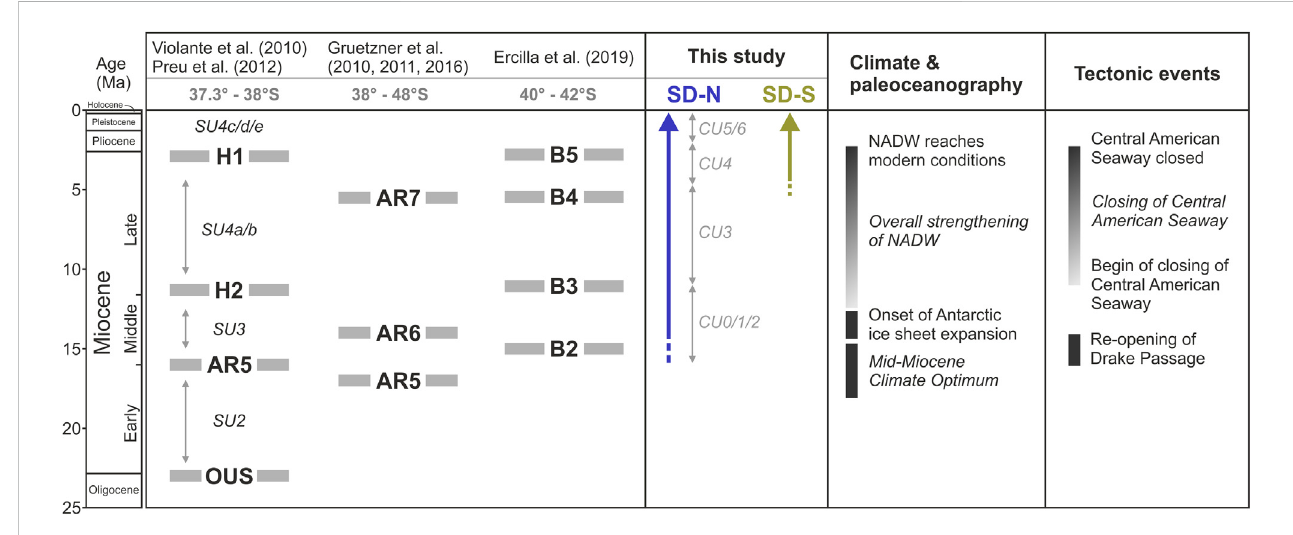
FIGURE 3 Overview of the relevant seismo-stratigraphy in the study area. Seismic horizons for three different stratigraphic schemes, approximate ages of SD-N (blue) and SD-S (green), main climate, palaeoceanographic and tectonic events used in the previous studies to reconstruct the evolution of the northern Argentine Continental Margin (from Violante et al., 2010; Gruetzner et al., 2011; Gruetzner et al., 2012; Preu et al., 2012; Gruetzner et al., 2016; Ercilla et al., 2019 and references